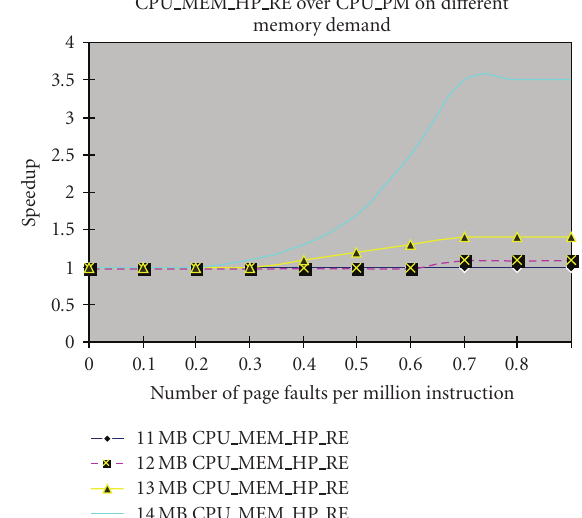
Figure 7: Paging time fractions in the total execution times for all the policies on “trace 0” with the mean memory demand of 14 MB at page fault of